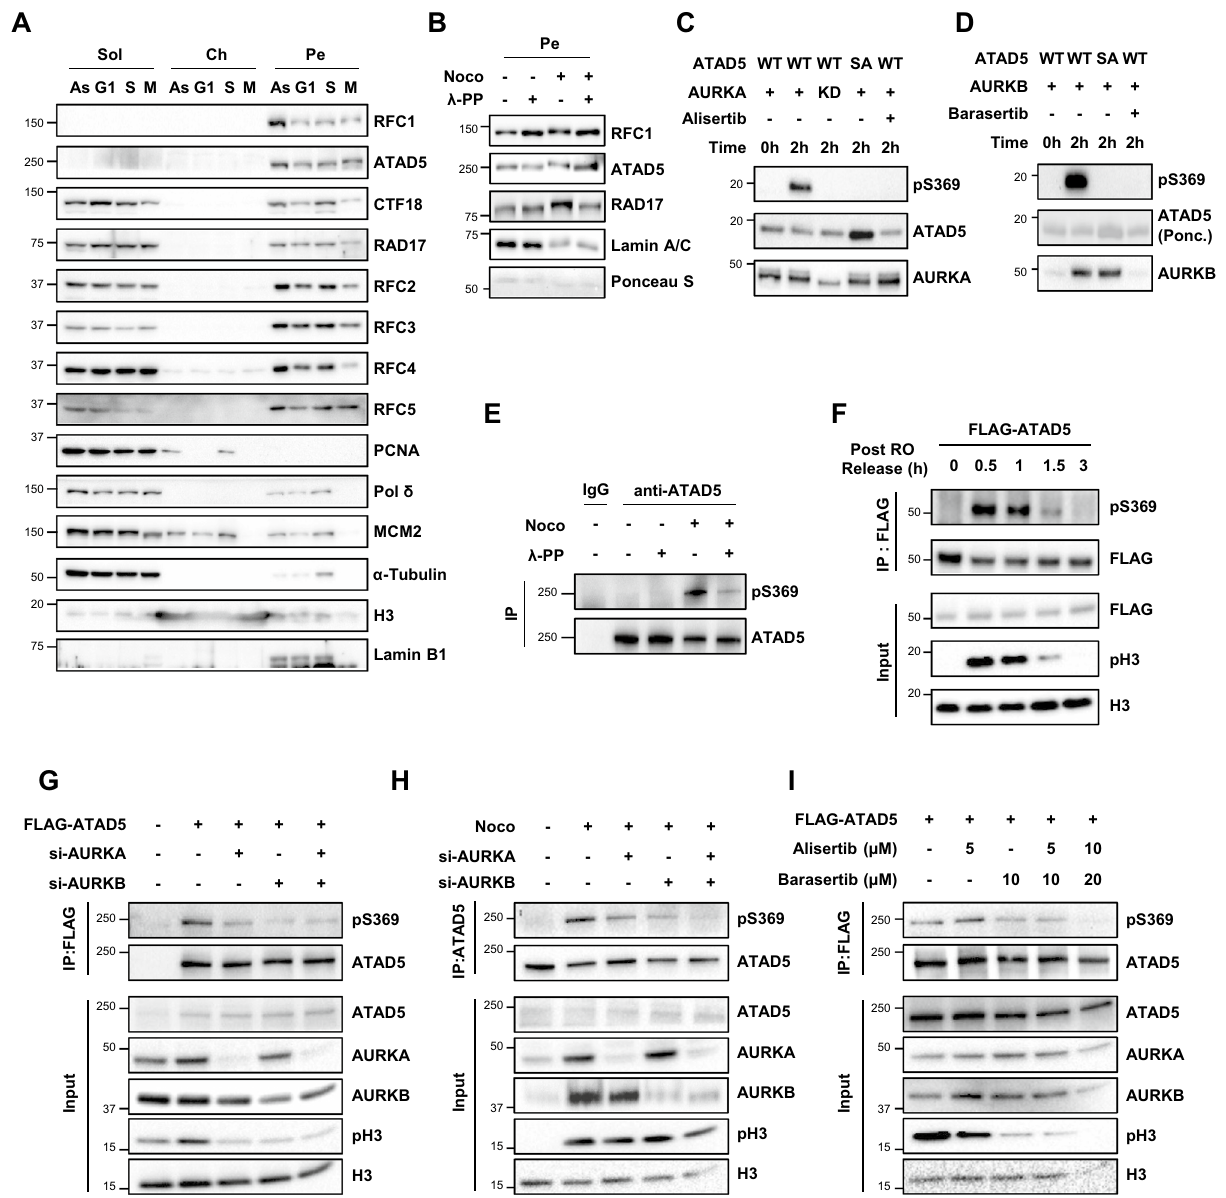
Figure 2. The fractionation profile of RFC/RLC proteins is maintained throughout cell cycle. ( A ) HeLa cells were arrested at the mitotic (M) phase using thymidine-nocodazole block and the shaked-off cells were re-seeded in fresh media and incubated for 4 h (G1) and 12 h (S). Cells at each phase and asynchronous (As) cells were collected, fractionated and subjected to immunoblotting. ( B ) HeLa cells asynchronous or arrested at the mitotic phase by treatment of nocodazole (Noco) were fractionated. Lambda phosphatase (λ-PP) (400 Unit/ sample) was added during the nuclease treatment step and pellet (Pe) fraction was subjected to immunoblotting. ( C , D ) The in vitro kinase assay. The purified wild-type (WT) or S369A (SA) mutant of ATAD5 fragment (residues 1–400) was incubated with the recombinant wild-type (+) or kinase-dead (KD) AURKA ( C ) or AURKB ( D ) for indicated times. Alisertib ( C ) or Barasertib ( D ) was added in the reaction as indicated. The reaction samples were subjected to immunoblotting. ( D ) ATAD5 was detected by Ponceau S (Ponc.) staining. ( E ) Whole-cell extracts were prepared from HEK293T cells asynchronous (Asy) or arrested at the mitotic phase by treatment of nocodazole, and then subjected to immunoprecipitation with anti-ATAD5 antibody. Lambda phosphatase (λ-PP) (400 Unit/sample) was added during the nuclease treatment step. ( F ) HEK293T cells were transfected with 3xFLAG-tagged ATAD5 fragment (residues 1–400) cDNA. One day after, cells were arrested at the G2 phase by treatment of RO-3306 (RO) for 16 h and released from the arrest during the indicated time. Whole-cell extracts were prepared for immunoprecipitation with anti-FLAG antibody. ( G – I ) HEK293T cells were transfected with a combination of 3xFLAG-tagged ATAD5 cDNA and AURK siRNAs ( G ), AURK siRNAs ( H ), or 3xFLAG-tagged ATAD5 cDNA ( I ) as indicated. After transfection, cells were arrested at the mitotic phase by treatment of nocodazole. ( I ) Cells were treated with kinase inhibitors. Then whole-cell extracts were prepared for immunoprecipitation with anti-ATAD5 ( H ) or anti-FLAG antibody ( G , I ). ( A – I ) Uncropped blot images are presented in Supplementary Fig.